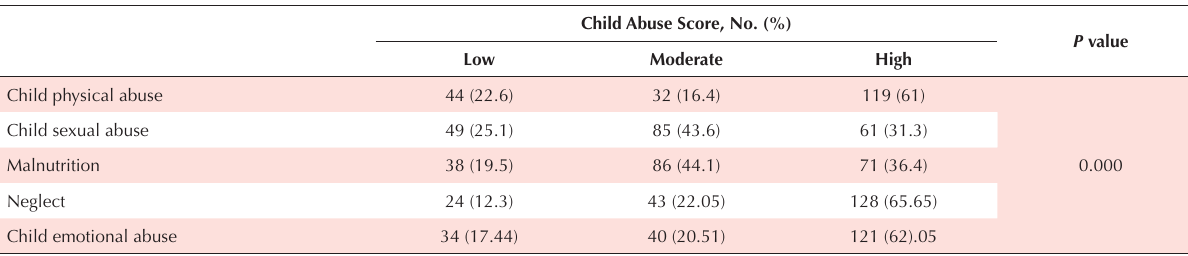
Table 3. The interpretation of different domains of child abuse questionnaire